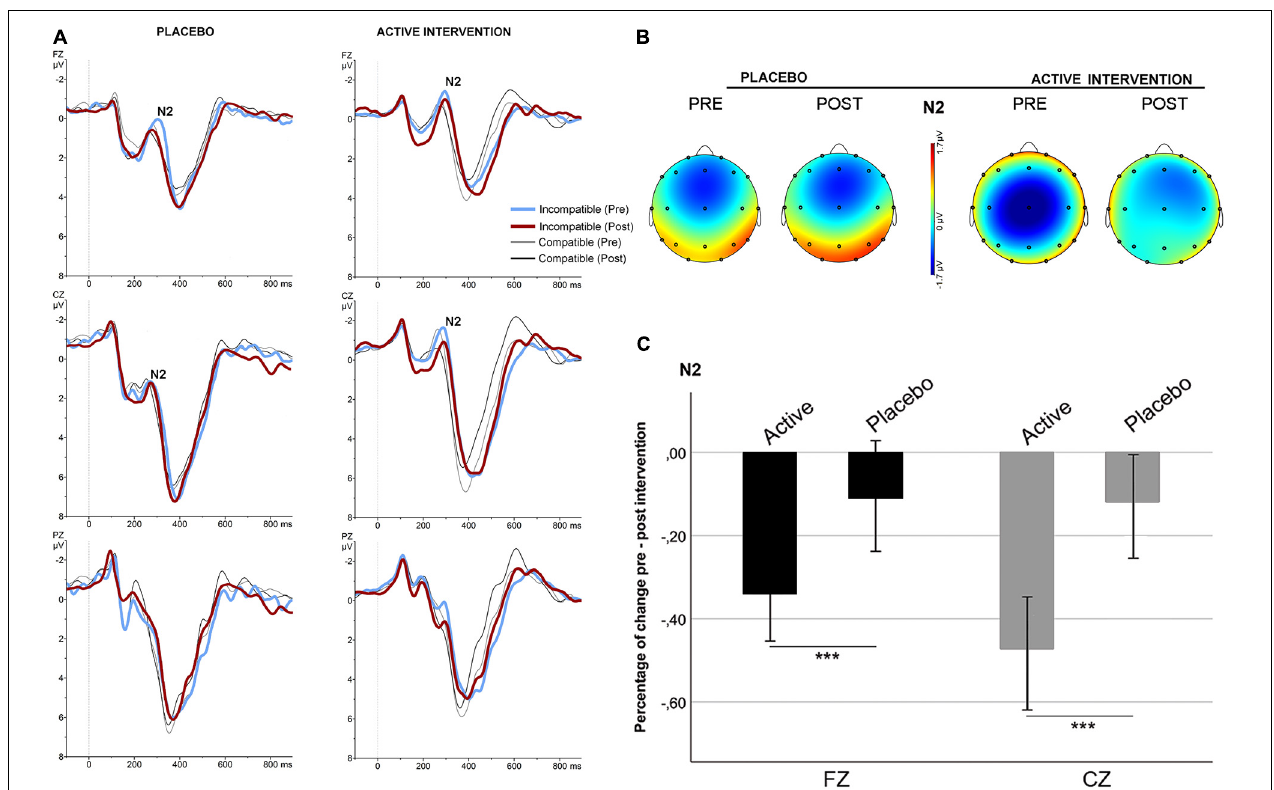
FIGURE 2 | Stimulus-locked (grand average) ERPs for the N2 in the two groups. (A) ERPs after correct compatible (thin line) and incompatible (thick line) trials in each group, pre (blue/gray) and post (red/black) intervention. (B) The topographical map shows the pre-post effect on the mean amplitude of the N2 for incompatible condition. (C) Mean percentage of N2 change (in mV) for incompatible condition between study groups. *** significantly different ( p <